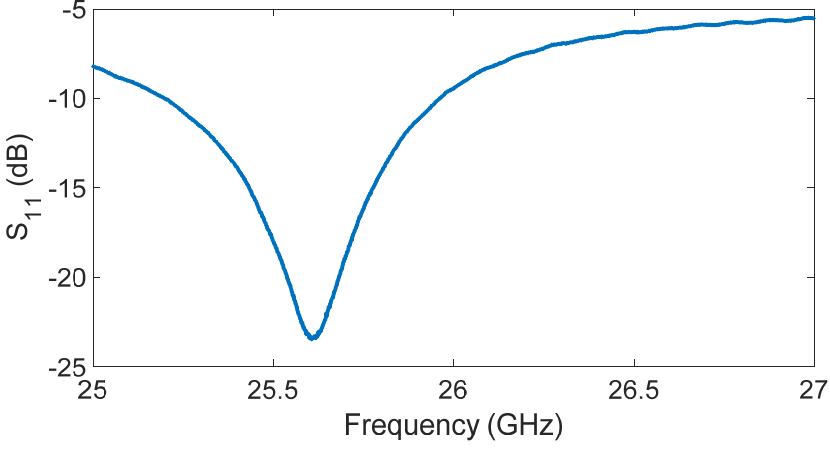
Figure 5. S 11 of the antenna in presence of water.